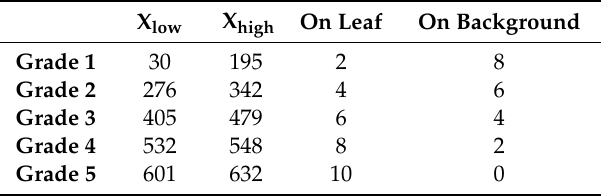
Table 2. Vertical boundaries for the five